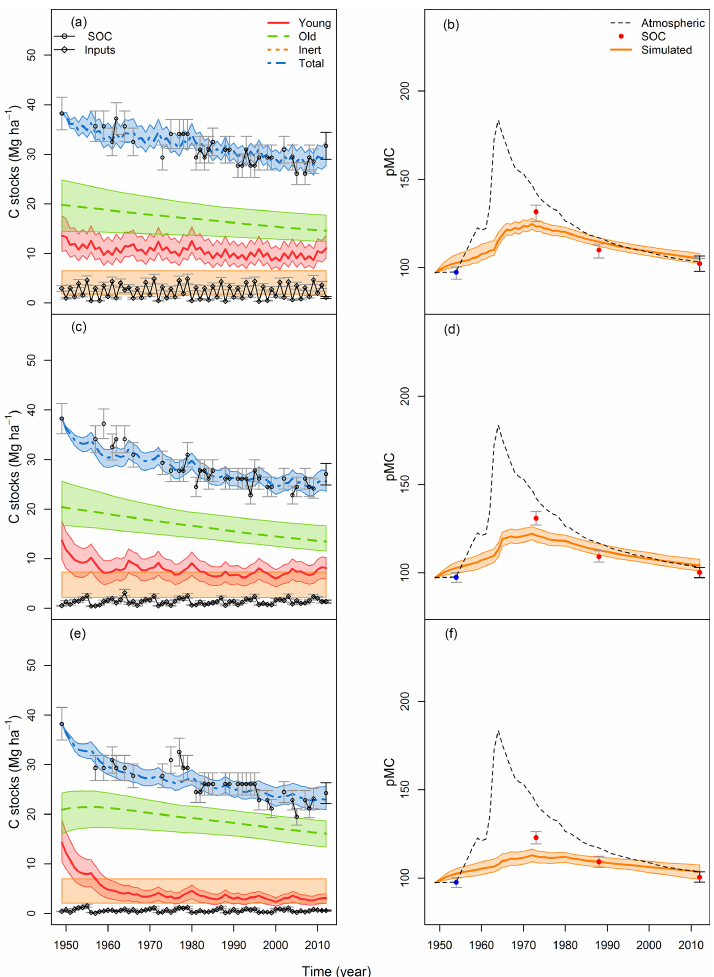
Figure 8. Simulation of SOC pools (a, c, e) and 14 C pools (b, d, f) in the ZOFE trial as described by model structure II, with weighting factor = 0.35, together with the measured data. Error bars represent the measured (black) and estimated (dark grey) standard error of the measurements. SOC (a, c, e) is in Mgha − 1 , while SO 14 C (b, d, f) is in